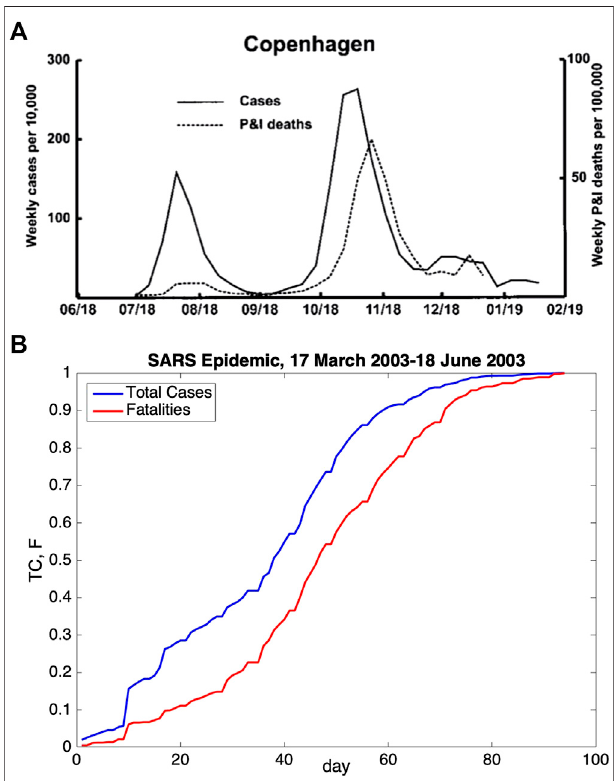
FIGURE 1 | (A) Weekly number of in fl uenza cases and respiratory deaths (pneumonia and in fl uenza) in Copenhagen, Denmark, during 1918 – 1919 are presented. This fi gure wastaken from the study ofAndreasen et al. [19] (copyright Andreasen et al. [19]). A shift occurred between the maxima of curves. (B) Daily number of total cases and cumulative number of the fatalities for the 2003 SARS epidemic in the world are shown. The data provided by WHO were used in the generation of this fi gure (https://www. who.int/csr/sars/country/en/) (last access: September 15, 2020). An explicit shift was also observed for the SARS